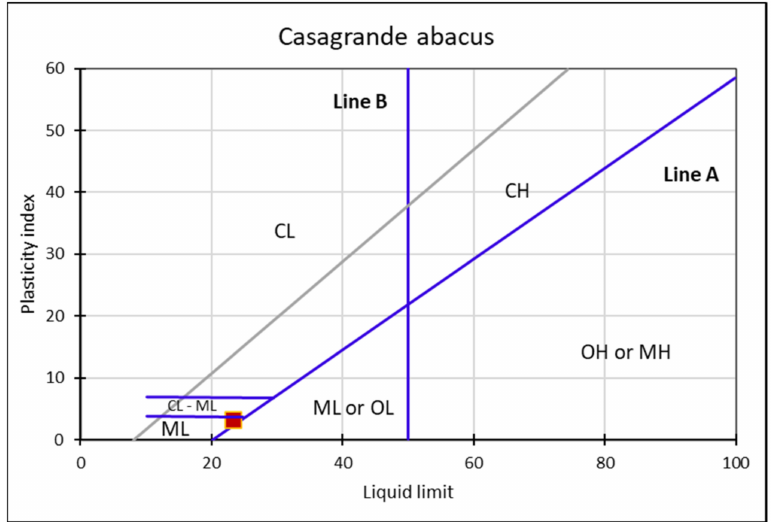
Figure 5. Casagrande